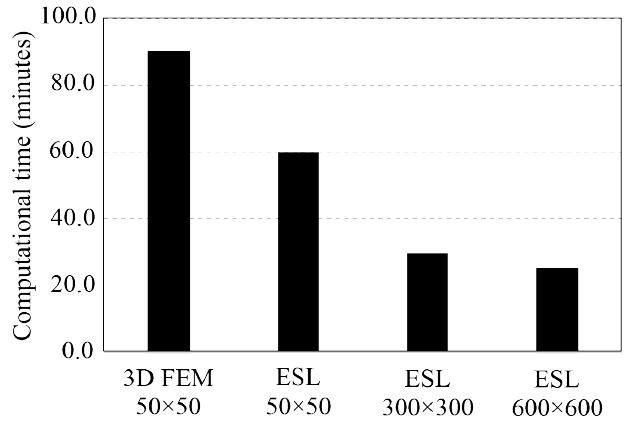
Figure 6. Computational time for 3D FEM and ESL with several mesh